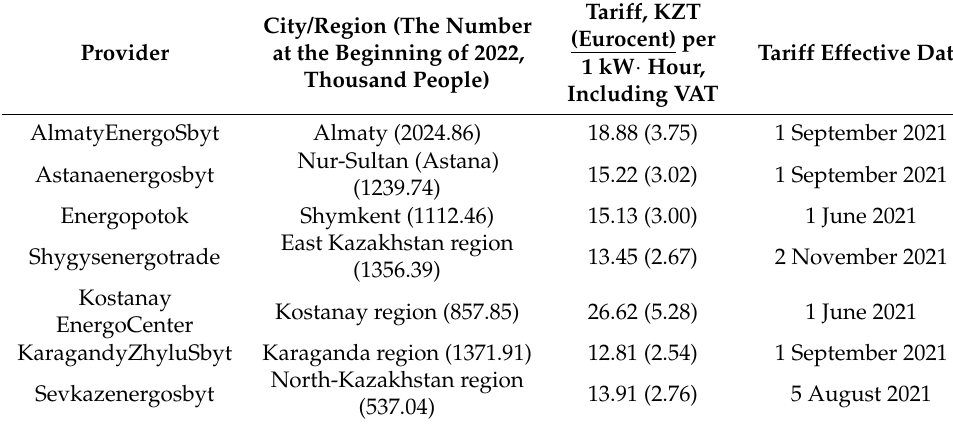
Table 2. Average electricity tariff for households by utilities.